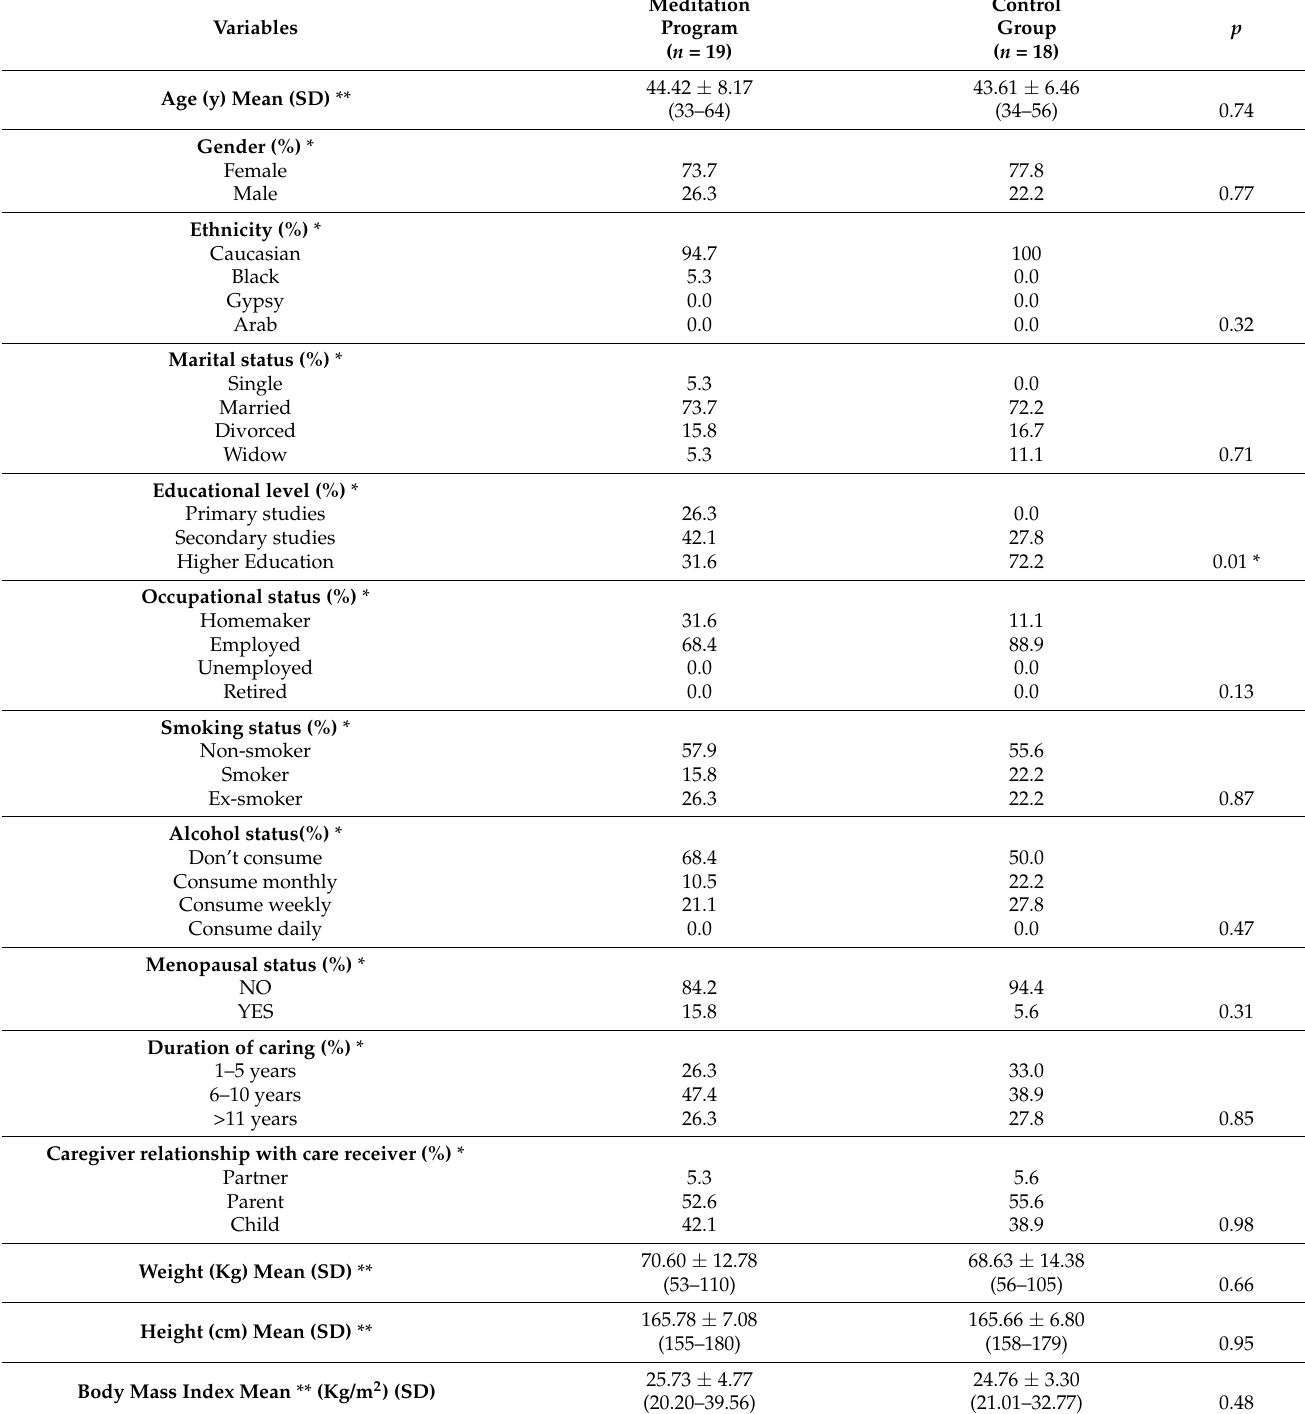
Table 1. Caregiver characteristics and comparisons between study